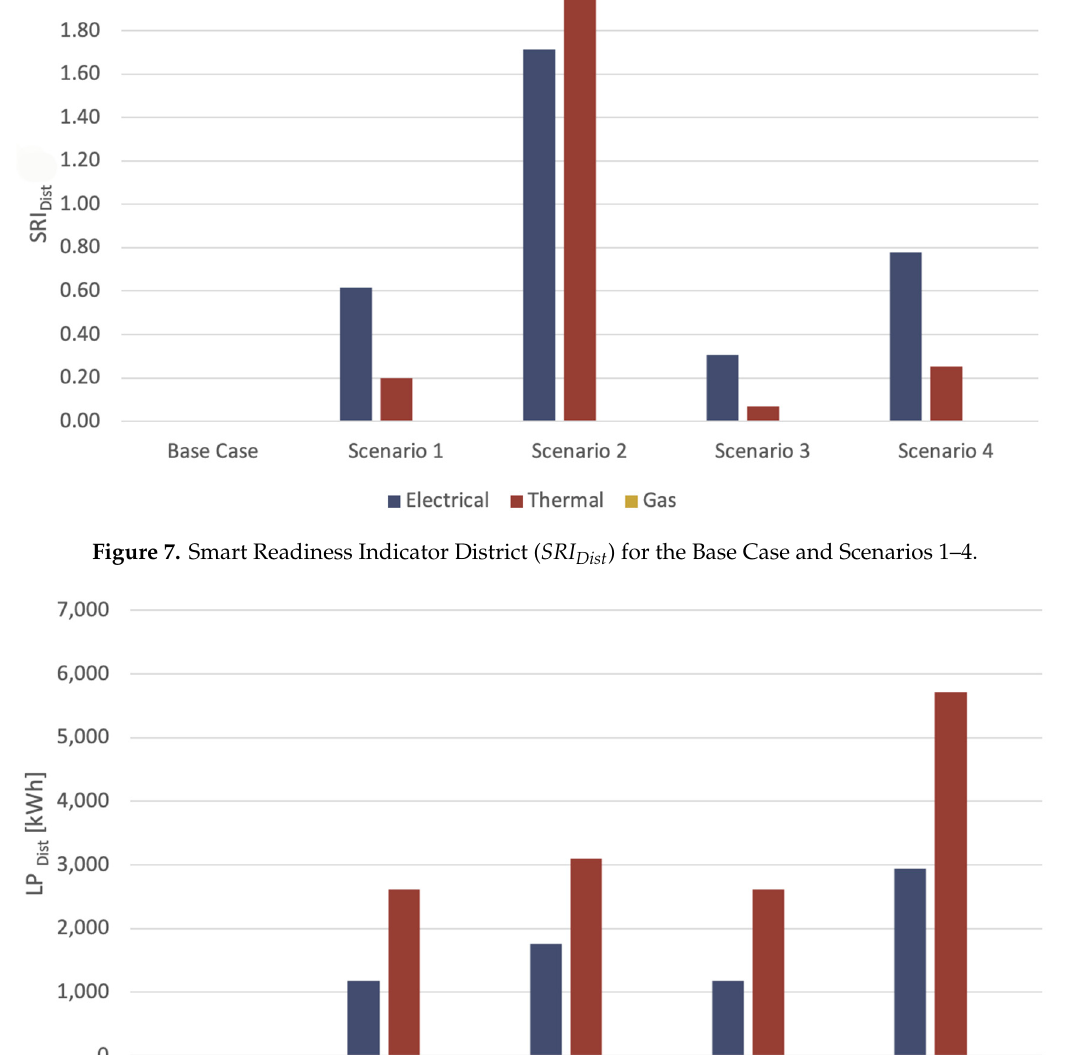
Figure 7. Smart Readiness Indicator District (SRI Dist ) for the Base Case and Scenarios 1–4. .